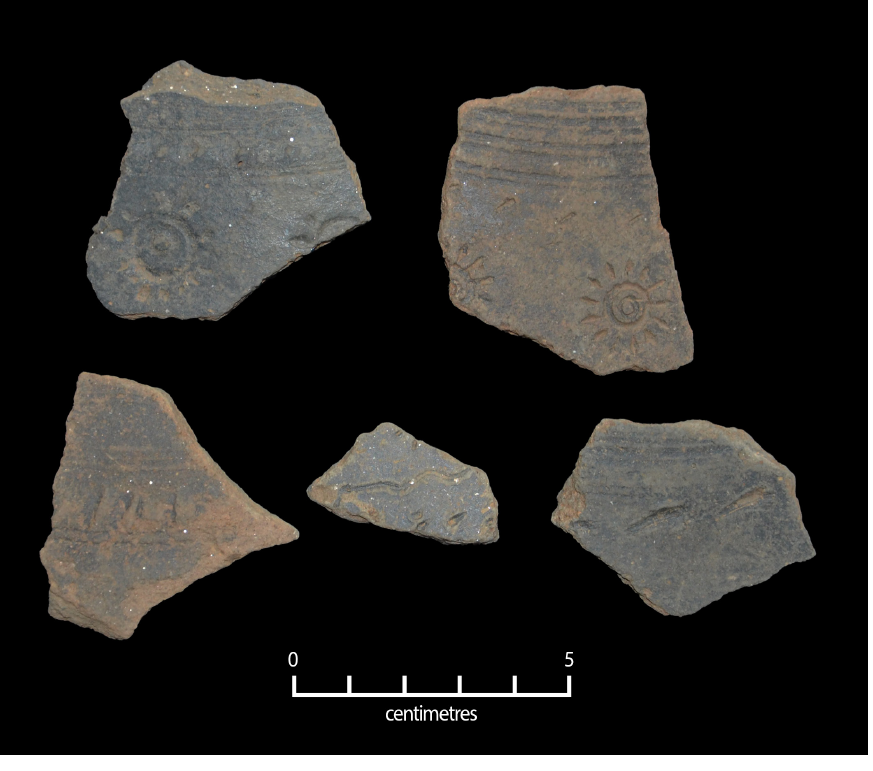
Figure 18: External surfaces of various Class 5 variant 4 potsherds, each exhibiting incised and impressed decoration.